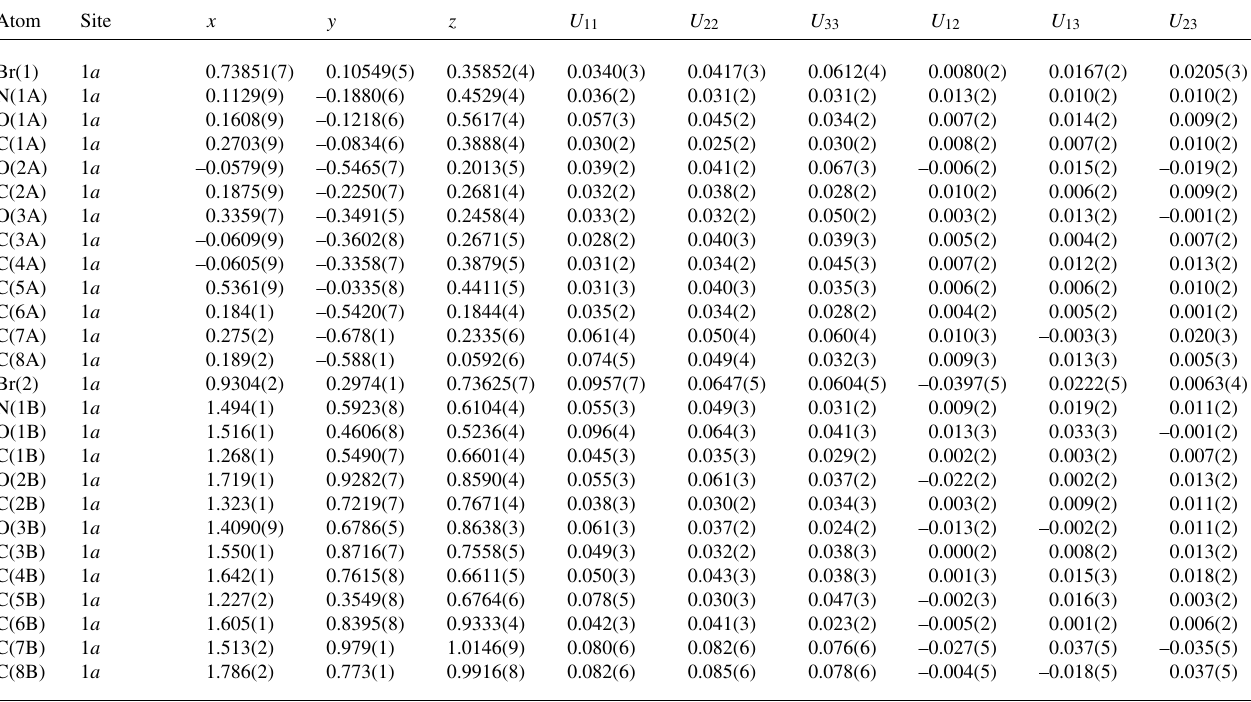
Table 3. Atomic coordinates and displacement parameters (in Å 2 )